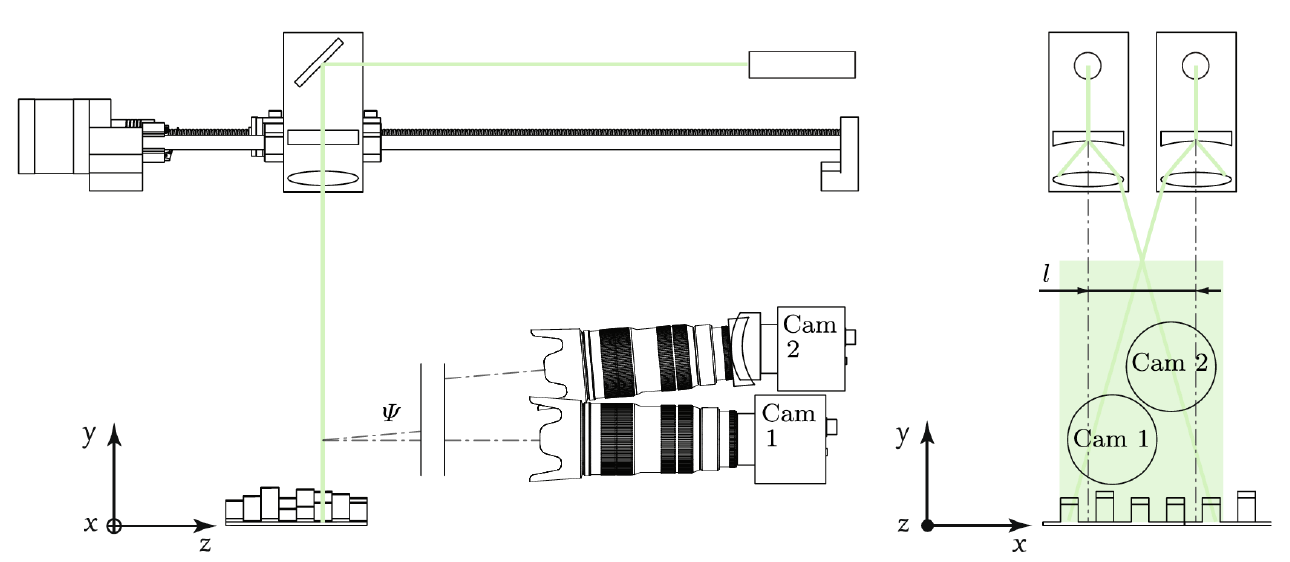
Figure 5. ( Left ) Front and ( right ) side view of PIV setup and measurement system used in the uniform- and variable-height experiments by from Ferreira and Ganapathisubramani [79]. Reprinted from Ref. [79], with permission of the publisher (Springer